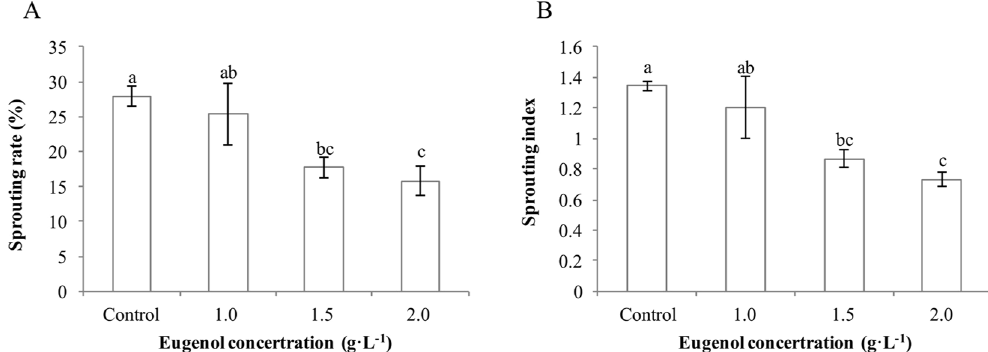
Figure 2. Effects of different concentrations of eugenol on the sprouting rate and sprouting index of Qian You 1 in the field. The data were the means of three replications, and the standard deviation was indicated by bars. Small letter (s) on top of bars indicated significant differences ( α = 0.05, LSD) among control and different eugenol treatments at a certain imbibition time.